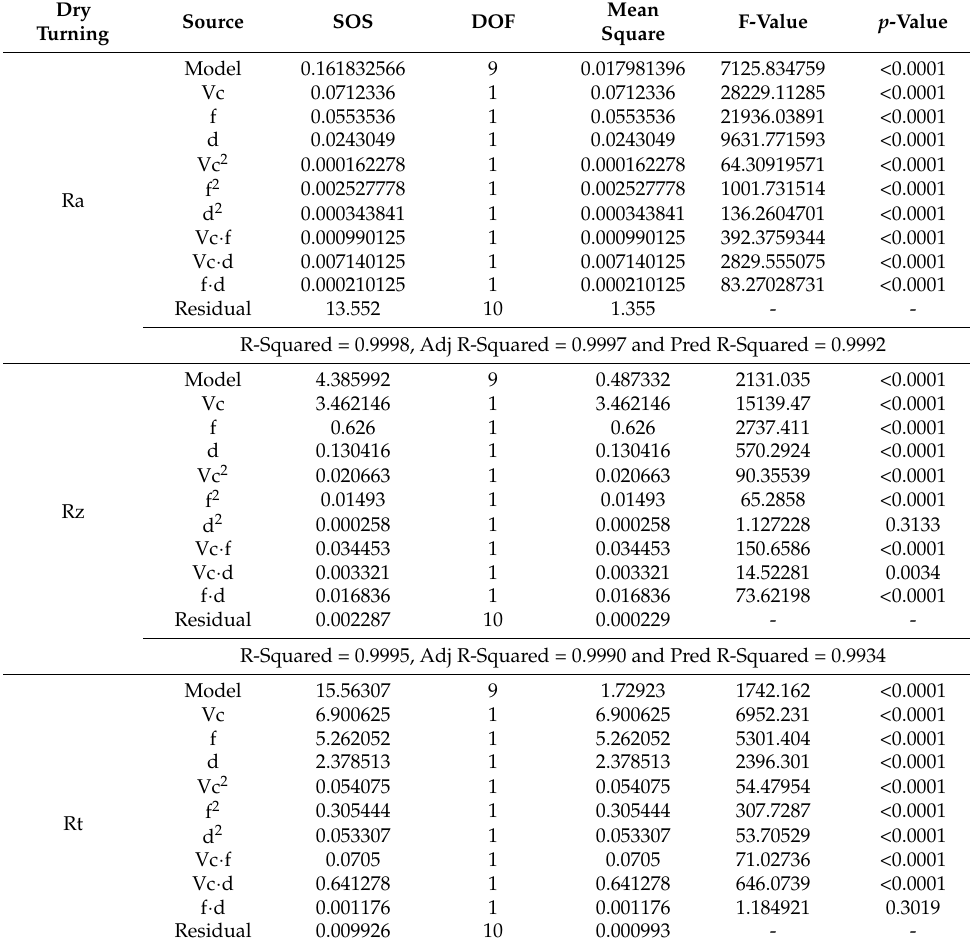
Table 5. ANOVA table for surface roughness for dry